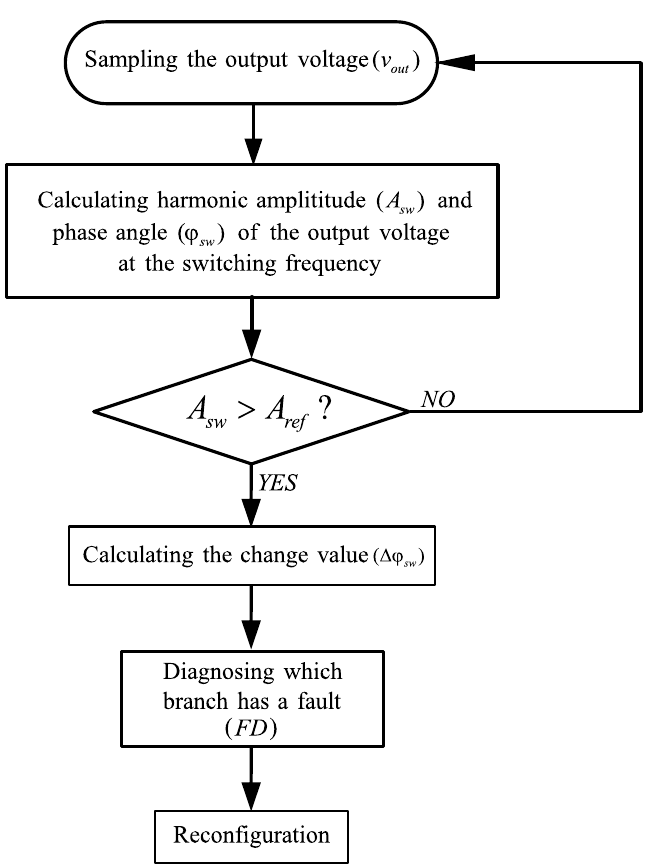
Figure 6. The flow steps of the proposed algorithm.